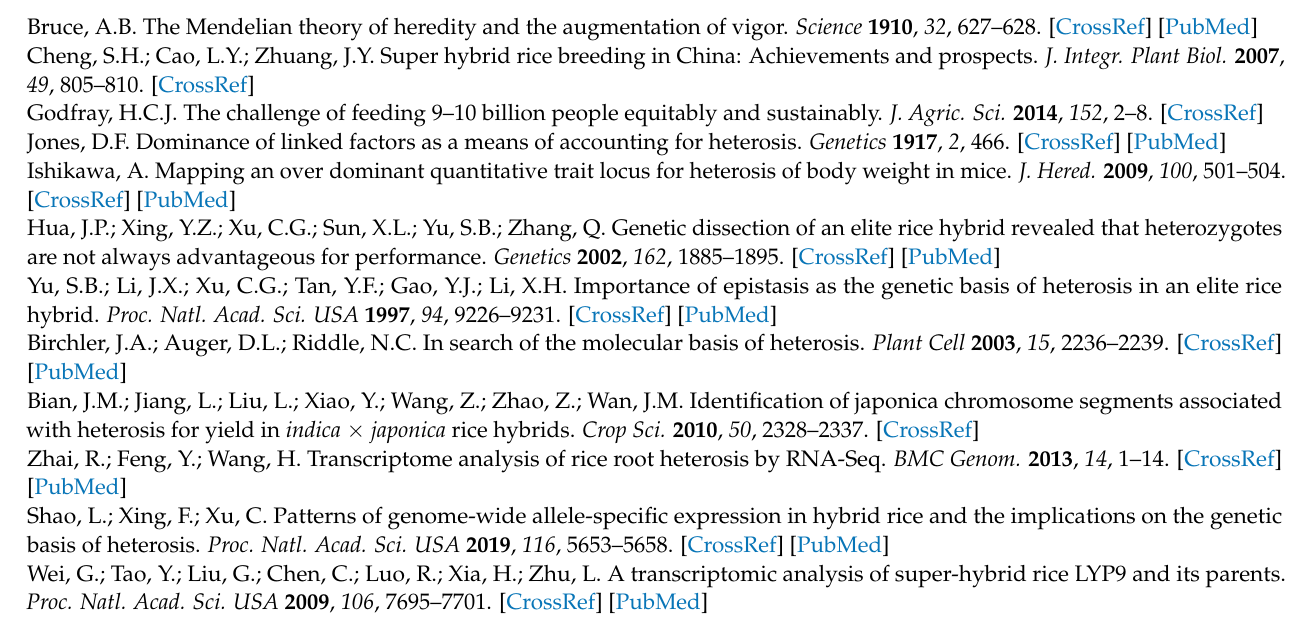
CHT025, and WFB grain shapes. Table S2: Number of mapped reads. Table S3: The total number of genes expressed (based on FPKM) in WFYT025 and its parents. Table S4: Primer sequences for qRT-PCR expression analysis. Table S5: Classification of DGHPs based on the dominance ratio HP in 1 DPA. Table S6: Classification of DGHPs based on the dominance ratio HP in 10 DPA. Table S7: Significant GO terms of DGHPs between WFYT025 and its parents in the biological process, cellular component, and molecular function category. Table S8: KEGG pathway enrichment of DGHPs between WFYT025 and its parents on the 1 and 10 DPA. Table S9: High-density genetic linkage map with 2,578 bin markers. Table S10: Phenotype values of grain shape in RIL populations. Table S11: Correlation coefficient of grain shape and grain weight relate traits. Figure S1: Candidate gene qRT-PCR expression results. (a) The qRT-PCR expression results of 10 candidate genes between WFYT025 and the parent on 1 DPA. (b) The qRT-PCR expression results of seven candidate genes between WFYT025 and the parent on 10